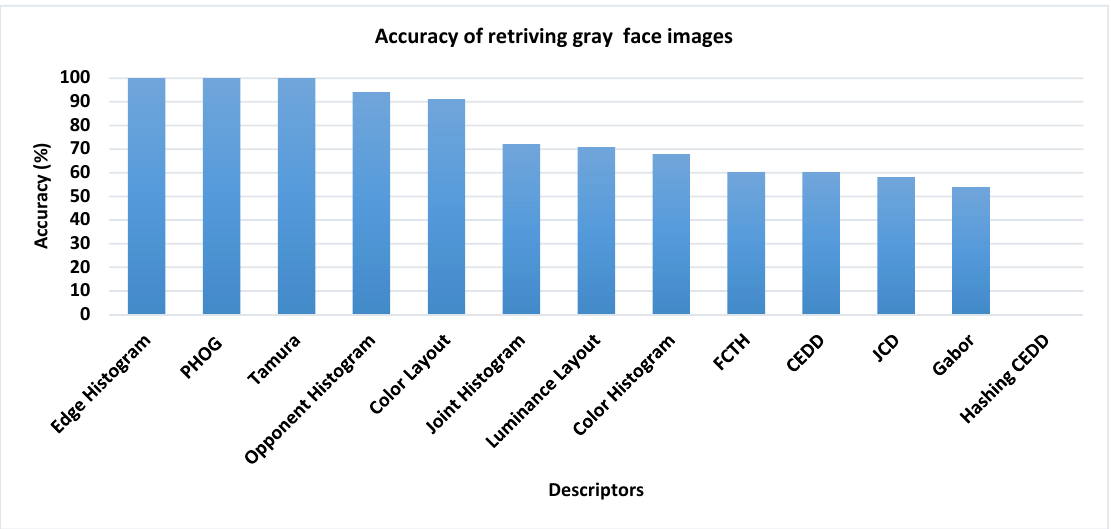
Figure 15. Average accuracy of retrieving grayscale face images.